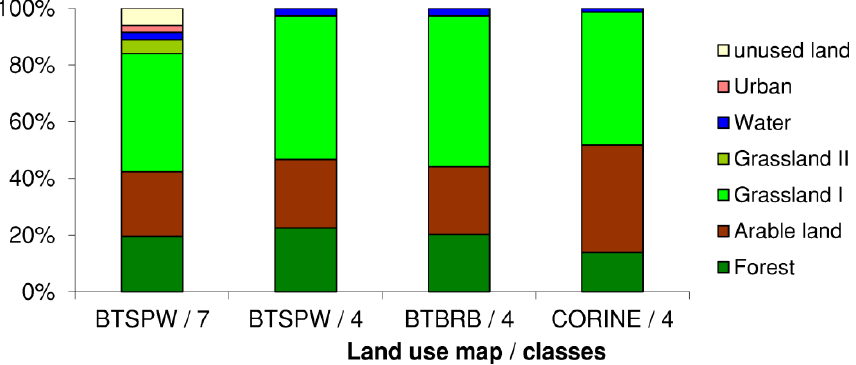
Figure 3. Fraction of land use classes in the land use maps BTSPW (seven and four classes), BTBRB (four classes), and CORINE (four classes).